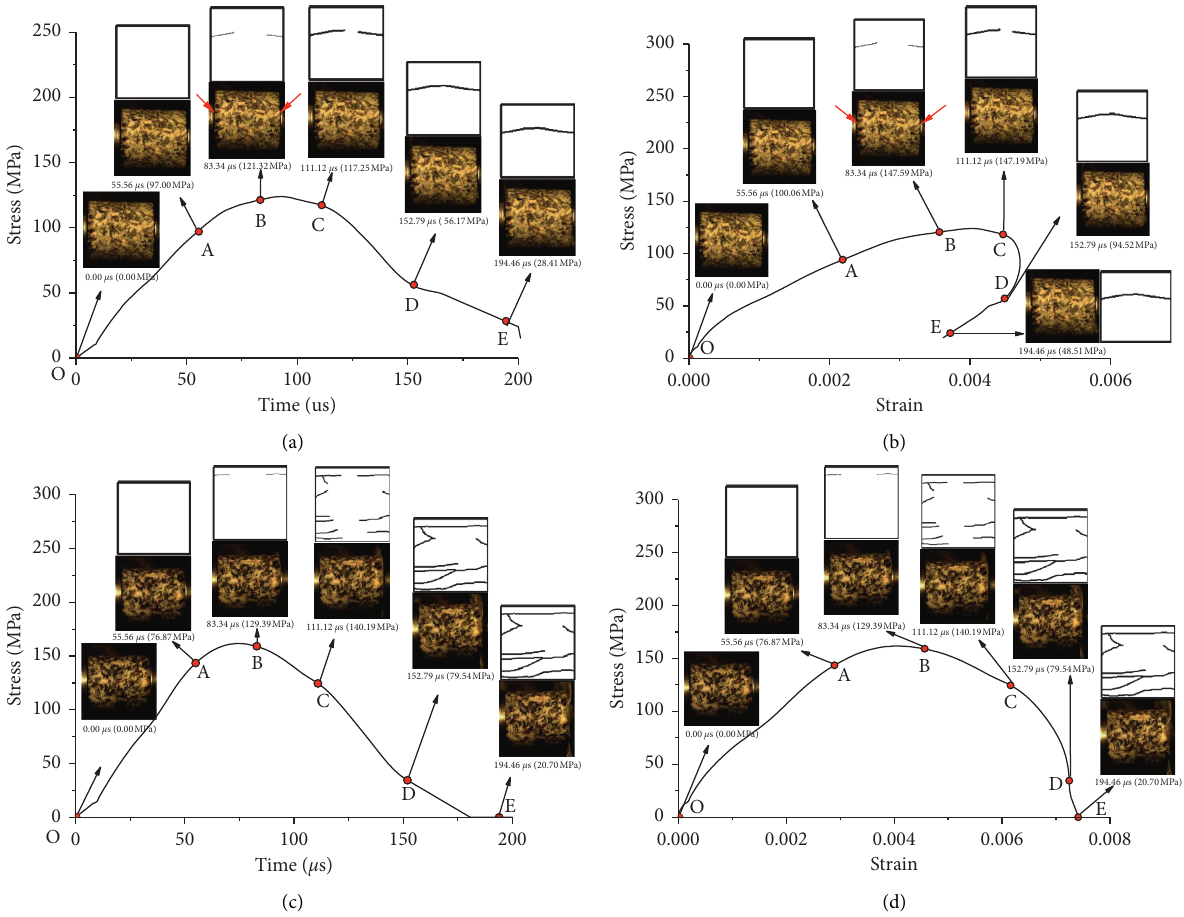
Figure 7: Stress-time and stress-strain curves of type II and III specimens with photos by high-speed camera: (a), (b) specimen G-8 in type II; (c), (d) specimen G-13 in type III.